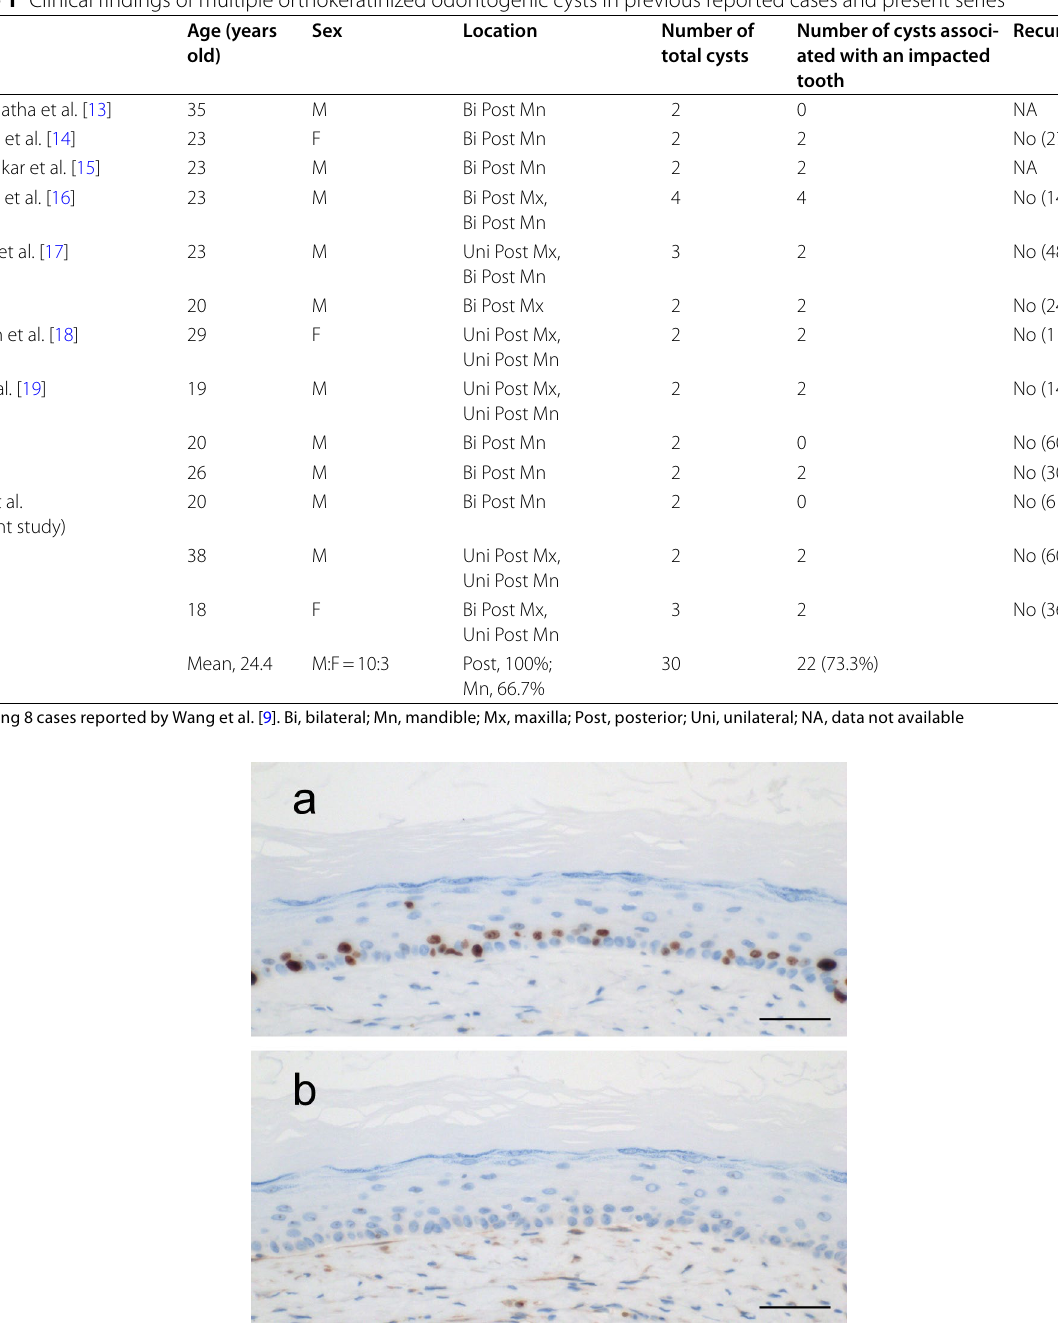
Molecular genetic findings PTCH1 mutations were evaluated in all seven OOCs. PTCH1 mutations were detected in six lesions collected in the three analyzed cases. Of the seven OOCs, PTCH1 mutations (p.P1315L) were identified in five OOCs (Cyst